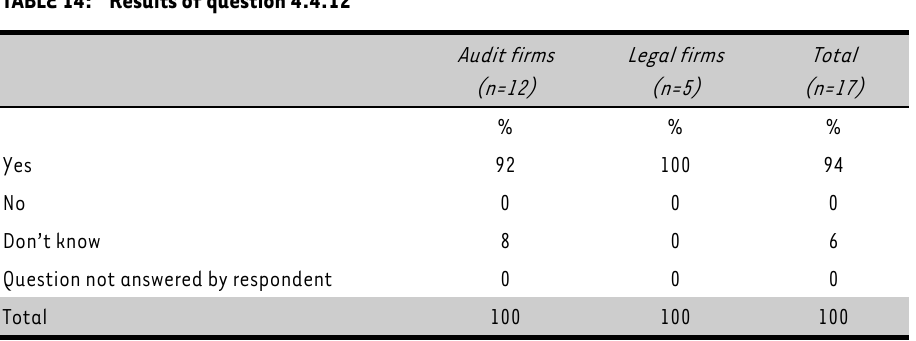
TABLE 14: Results of question 4.4.12